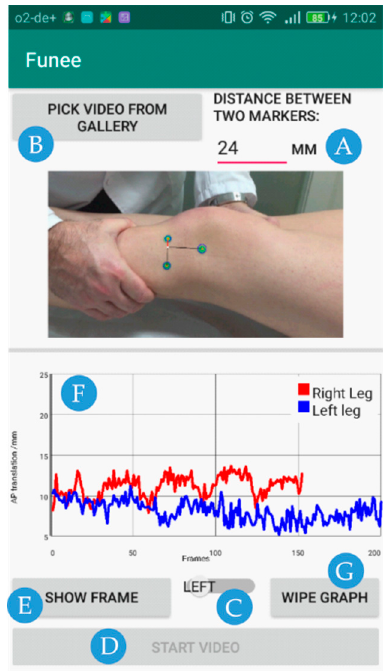
Figure 2. Main screen of the Android application. ( A ): Introduction of the distance between tibia’s markers. ( B ): Selection of the video. ( C ): Choice of left or right leg. ( D ): Starting of the video processing. ( E ): Visualization of the image frame. ( F ): Box showing the plot of AP translation. ( G ): Image refreshing.